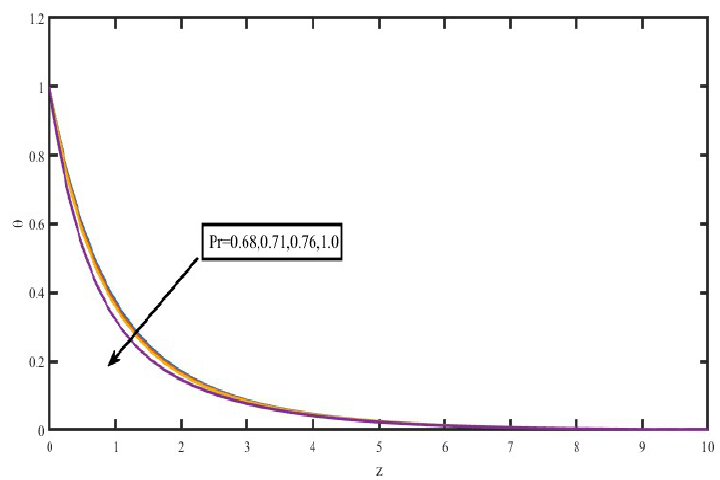
Figure 15. Temperature profiles for Prandtl number (Pr).